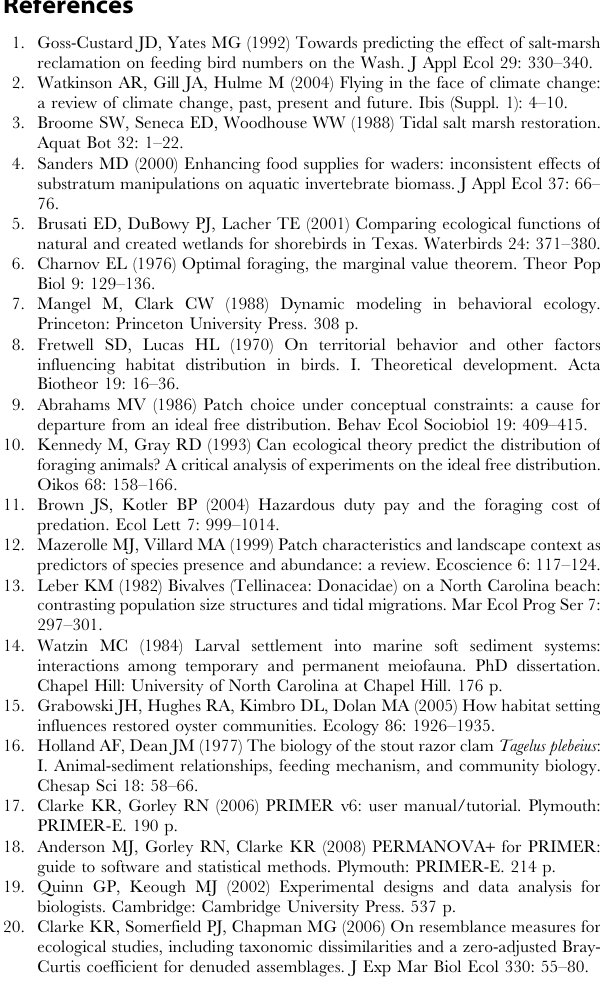
Table S2 Benthic macrofaunal species found in at least five percent of samples. Table S3 Phylum Polychaeta densities (organisms m 2 2 ) by flat. Table S4 Phylum Arthropoda densities (organisms m 2 2 ) by flat. Table S5 Phylum Mollusca densities (organisms m 2 2 ) by flat. Table S6 Flat-specific densities (organisms m 2 2 ) of organisms from additional phyla. Table S7 Results of one-way ANOVAs comparing ben- thic invertebrate abundance among tidal flats at each tidal stage, and post hoc contrasts using Tukey-Kramer HSD. Table S8 Results of one-way ANOVAs comparing ben- thic invertebrate biomass among tidal flats at each tidal stage, and post hoc contrasts using Tukey-Kramer HSD.